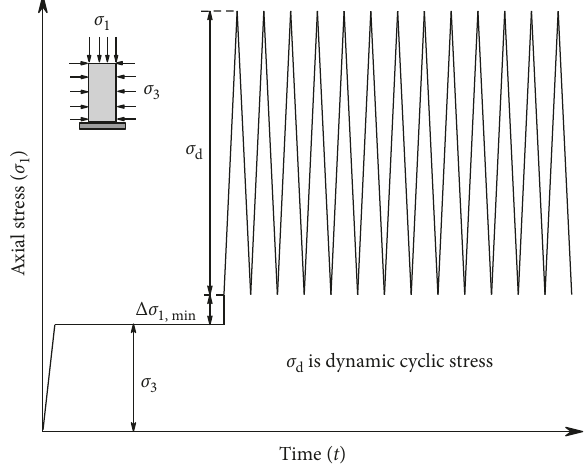
Figure 5: Loading history in cyclic triaxial tests.